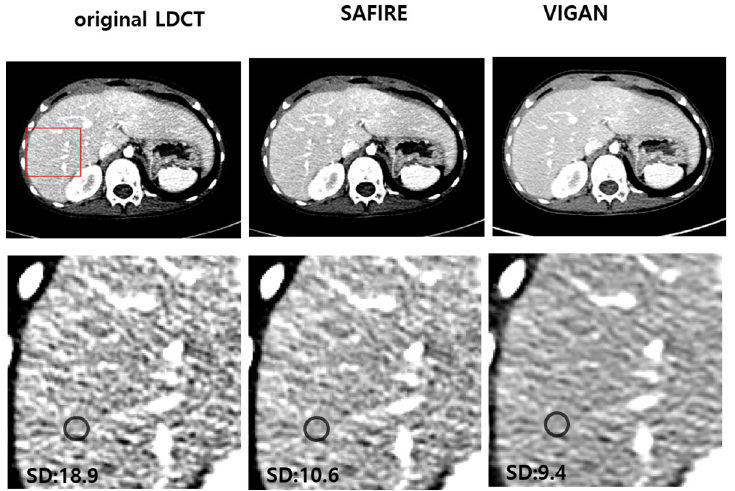
Fig 6. Images of original LDCT, SAFIRE, and VIGAN for test dataset. The second row shows zoomed regions-of- interests marked with the red rectangle in the images of the first row. The image noise (i.e., standard deviation(SD)) of VIGAN was lower than that of original LDCT and similar to that of SAFIRE. WL/WW = 125/230 for original LDCT and SAFIRE. WL/WW = 75/230 for